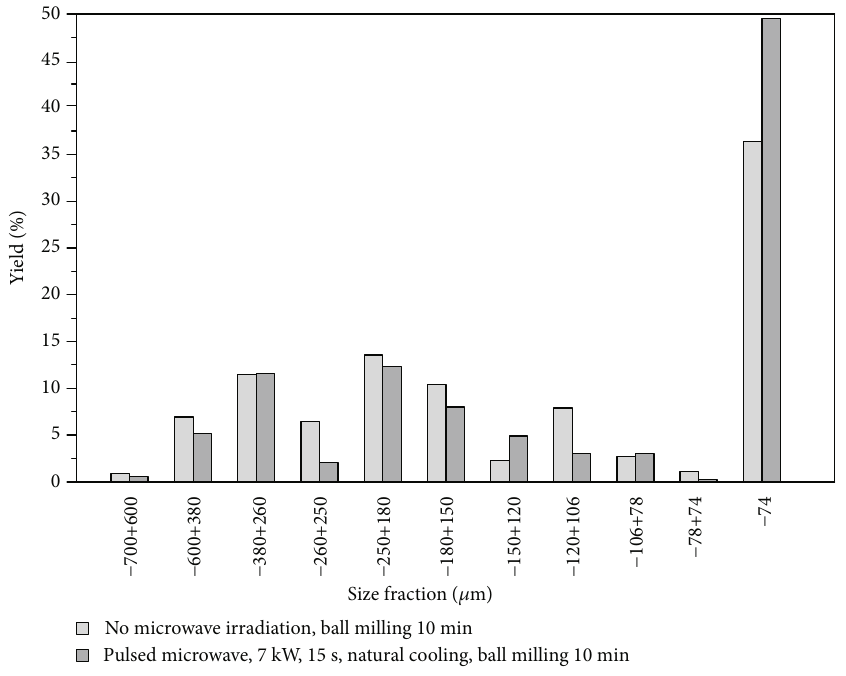
Figure 7: E ff ect of pulsed microwave pretreatment on size fraction distribution of grinding products for lead-zinc ore.